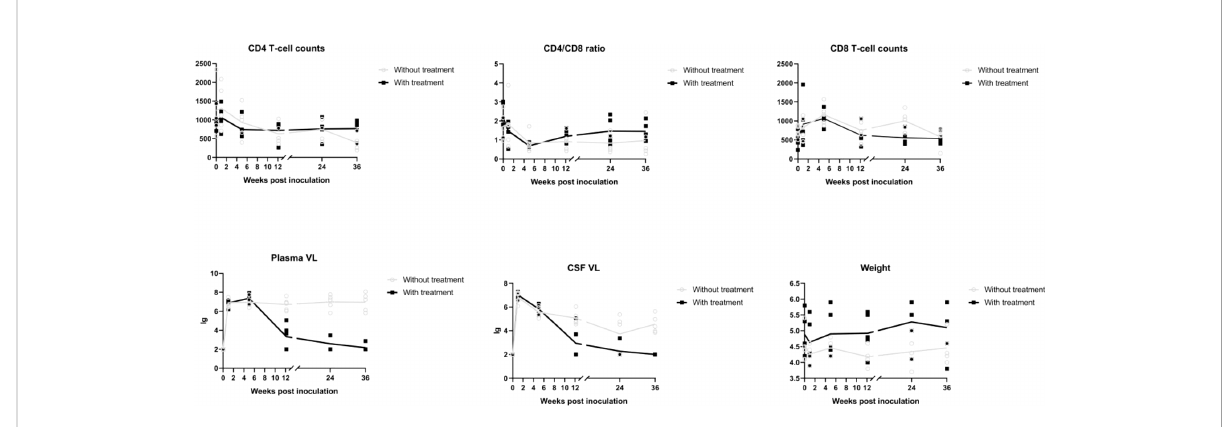
FIGURE 3 Alterations of CD4 T cell counts, CD8 cell counts, CD4/CD8 ratio, plasma viral load, CSF viral load in different time points of macaues with and without cART